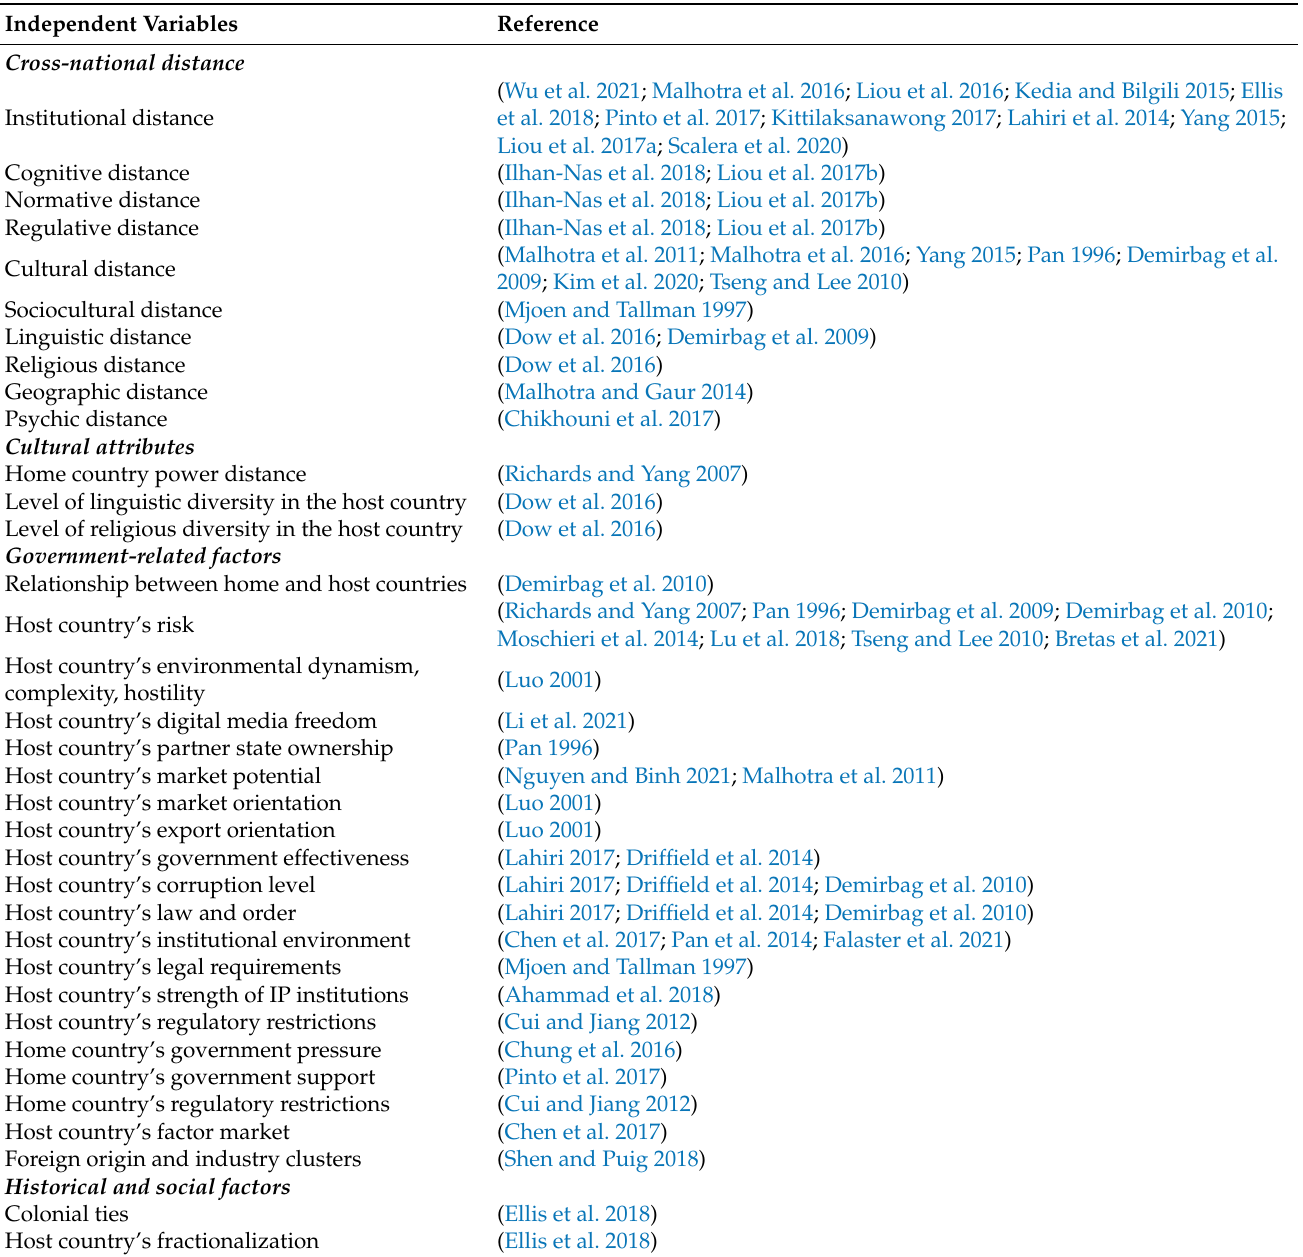
Table 3. Country-level environmental volatility factors that affect EMNEs’ entry mode